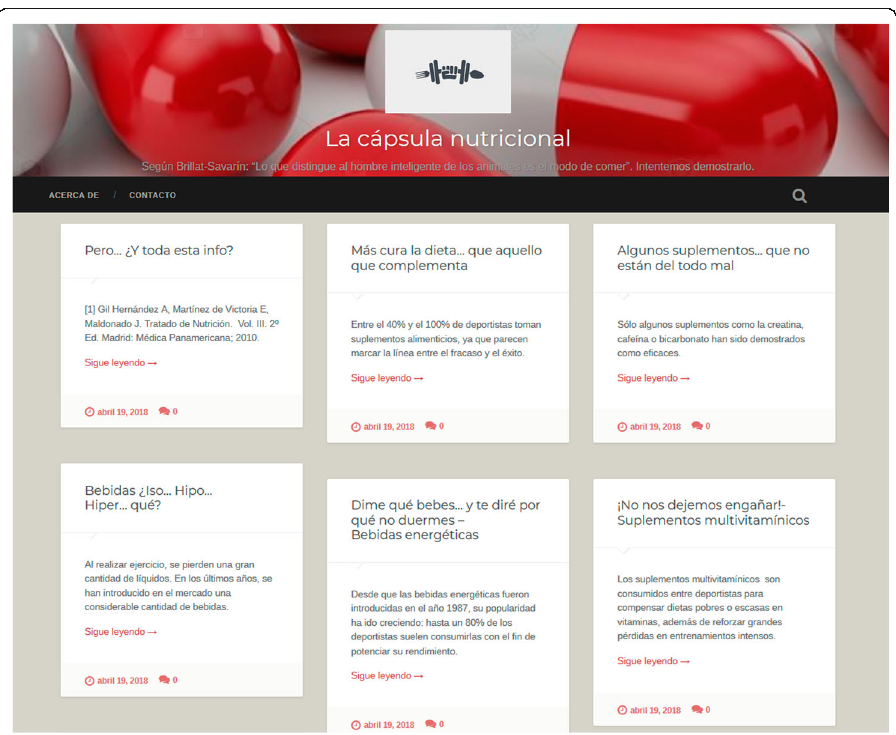
Fig. 5 Snapshot of a blog created by a group of students. Each group had to develop a blog as a project for the course. Each blog presents solutions to a specific problem in the subject area. A total of 15 group blogs were created. Available at: